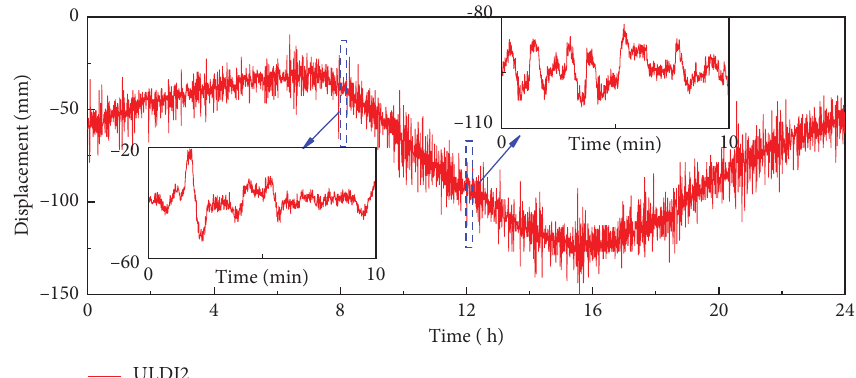
Figure 6: Time-history curve of daily longitudinal displacement at the girder